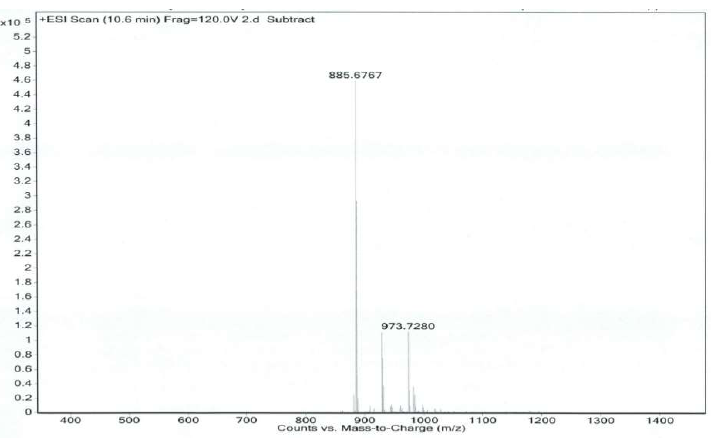
Figure 5. MS / MS spectrum of Co-Q10 reference substance. Figure 5. MS/MS spectrum of Co-Q10 reference substance. Figure 5. MS/MS spectrum of Co-Q10 reference substance. Figure 5. MS/MS spectrum of Co-Q10 reference substance.